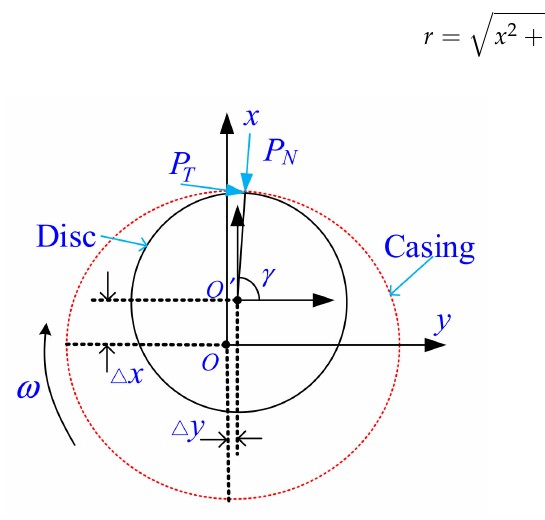
Figure 3. Sketch of the rub-impact phenomenon between the disc and